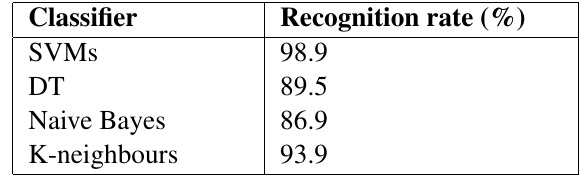
Table 4 Comparison of classification results of different